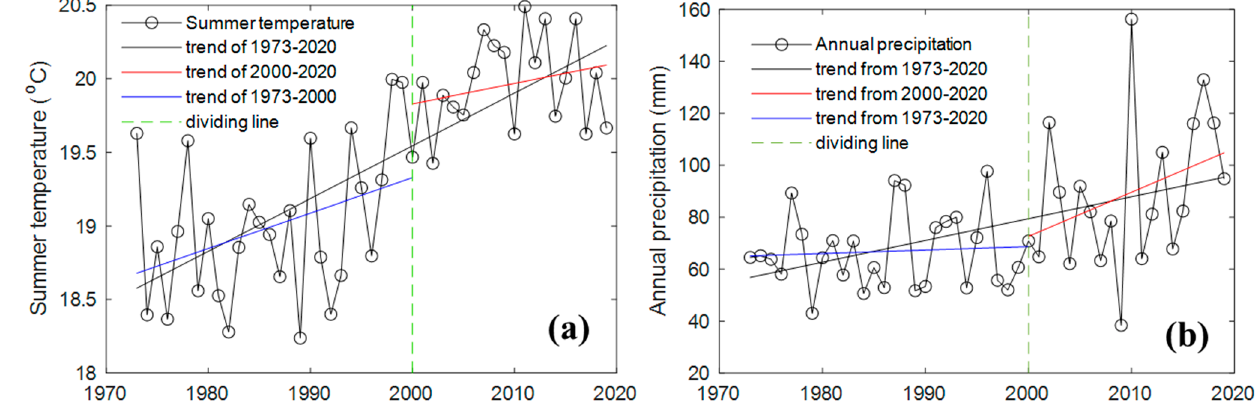
Figure 10. Summer temperature ( a ) and annual precipitation ( b ) changes in the WKM region.